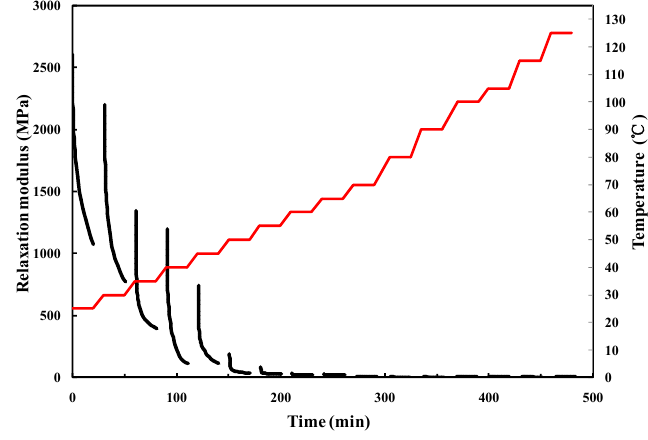
Figure 3. Stress–relaxation test results.